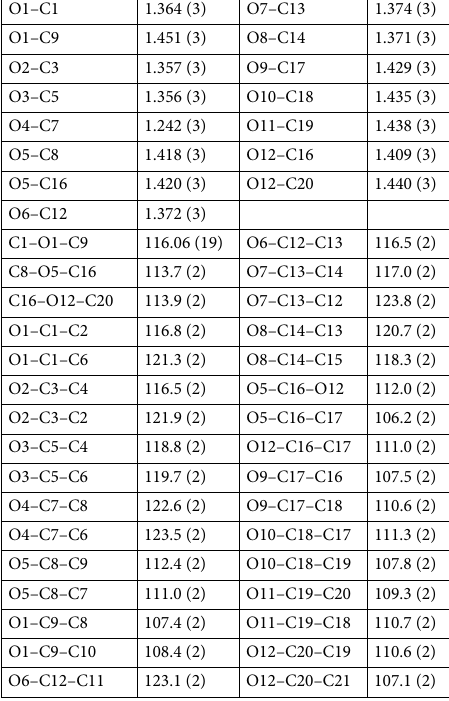
Table 1. Specified bond lengths and angles (Å, °).